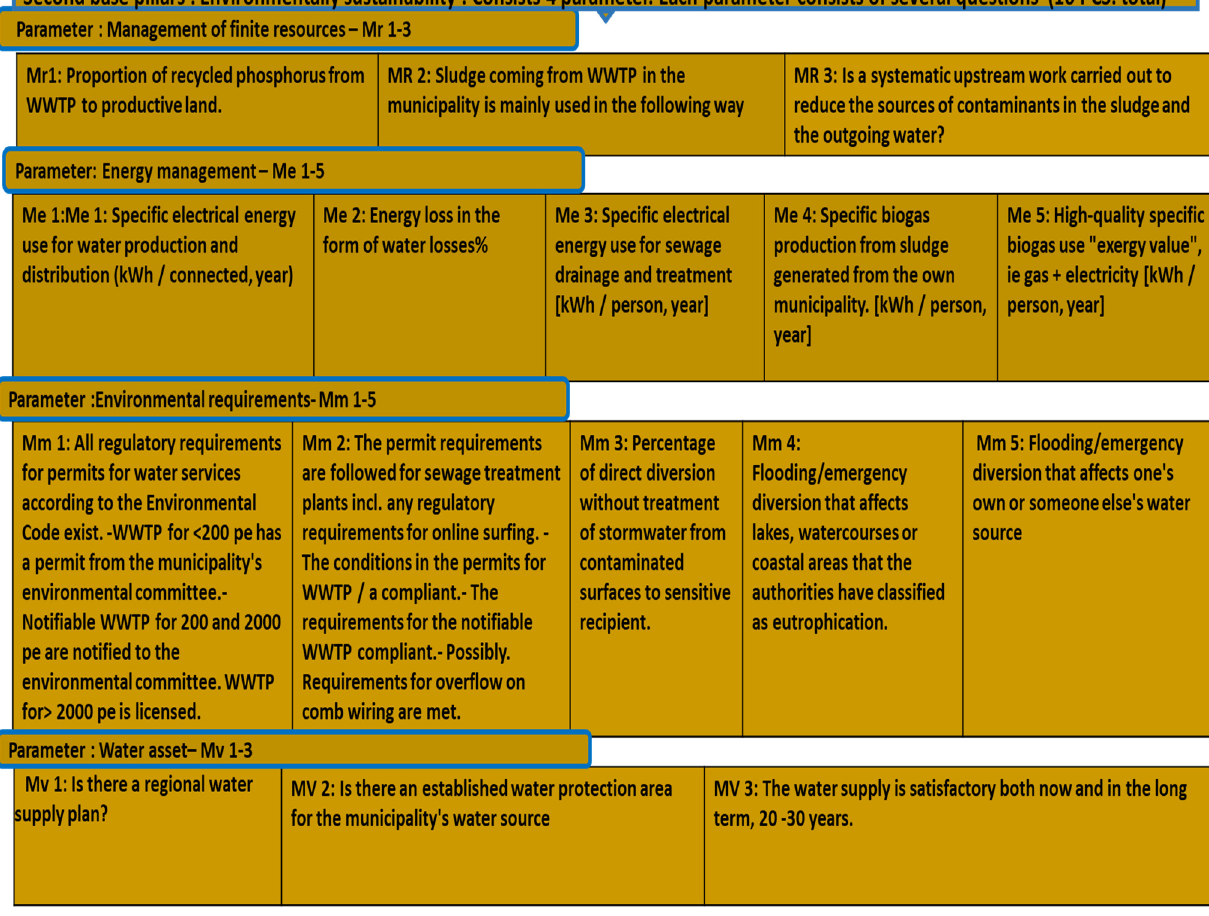
Figure A2. “Environmental sustainability” pillar, four related parameters, group codes for parameters, and related questions (key figures).